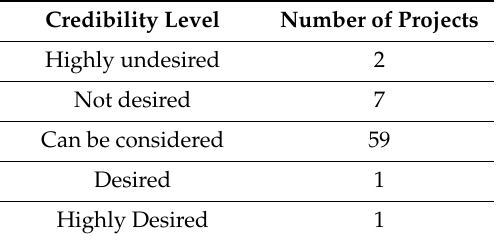
Figure 6. Authenticity estimation for canceled projects. Table 9. Statistical analysis of credibility assessment of canceled projects (Total projects = 70).